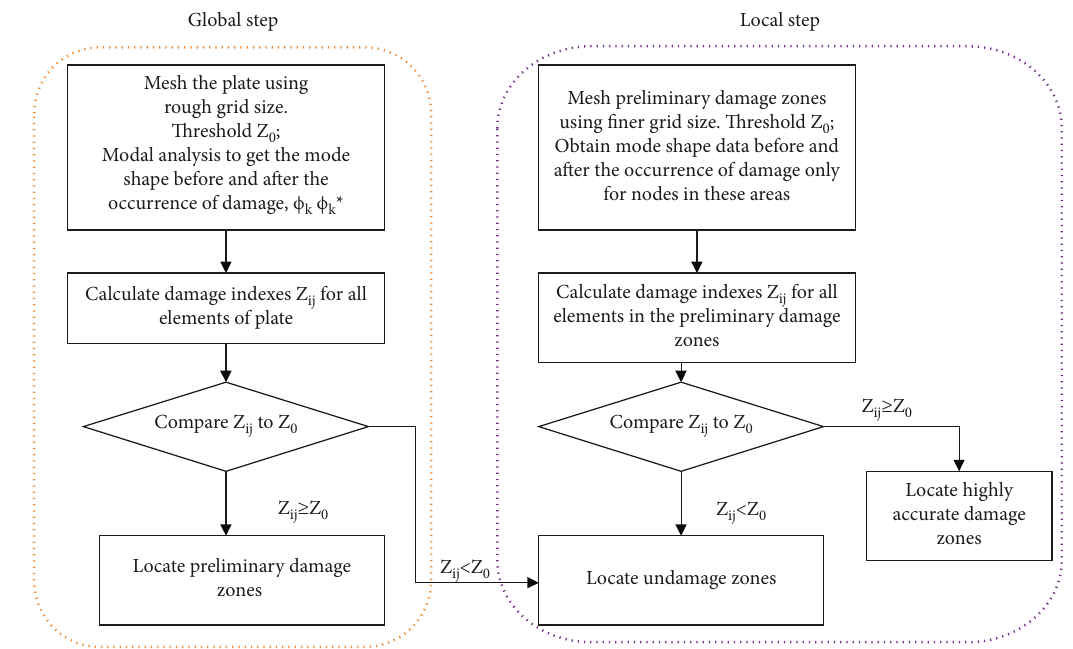
Figure 5: The proposed two-step MSE-based damage localization procedure.